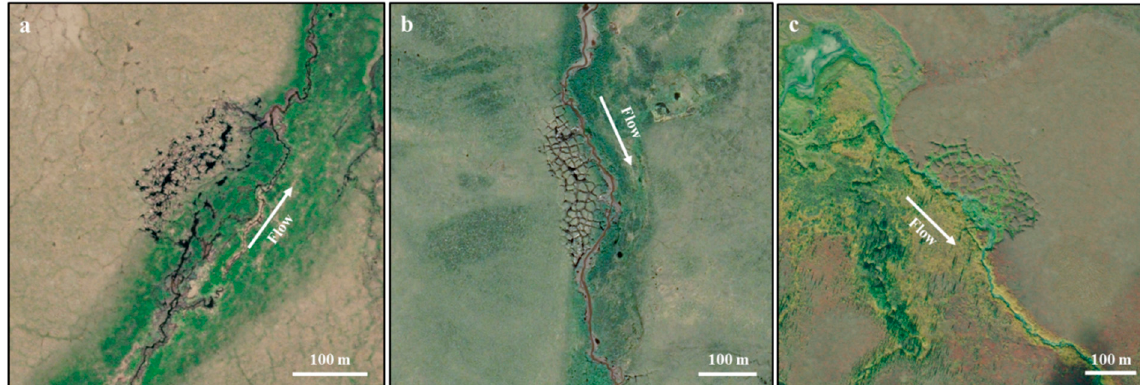
Figure 12. VHRS imagery showing examples of similar landscape settings where the combined actions of beaver-induced permafrost degradation processes (fluvio-thermal erosion, thermal erosion, and subsequent thermokarst processes) are likely responsible for the development of the landform. Beaver-induced permafrost degradation features at ( a ) the Swan Lake Creek site, Seward Peninsula, Alaska (6 June 2020), ( b ) Ptarmigan Creek, Seward Peninsula, Alaska (6 July 2019), and ( c ) an unnamed creek near Noatak, Alaska (6 September 2018). Recognition of the potential role of beaver engineering on permafrost degradation may help to characterize similar features across low Arctic and Boreal landscapes. All images are copyright DigitalGlobe, Inc.